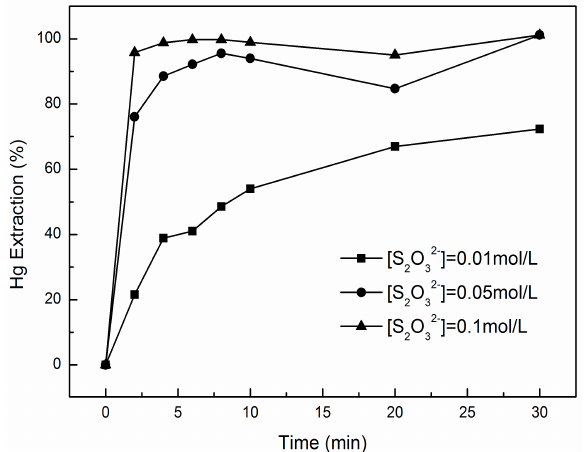
Figure 3. Effect of Na 2 S 2 O 3 concentrations on Hg extraction (Initially, 0.4 g HgO was mixed with 500 mL Na 2 S 2 O 3 solution, 20 ± 1 °C).